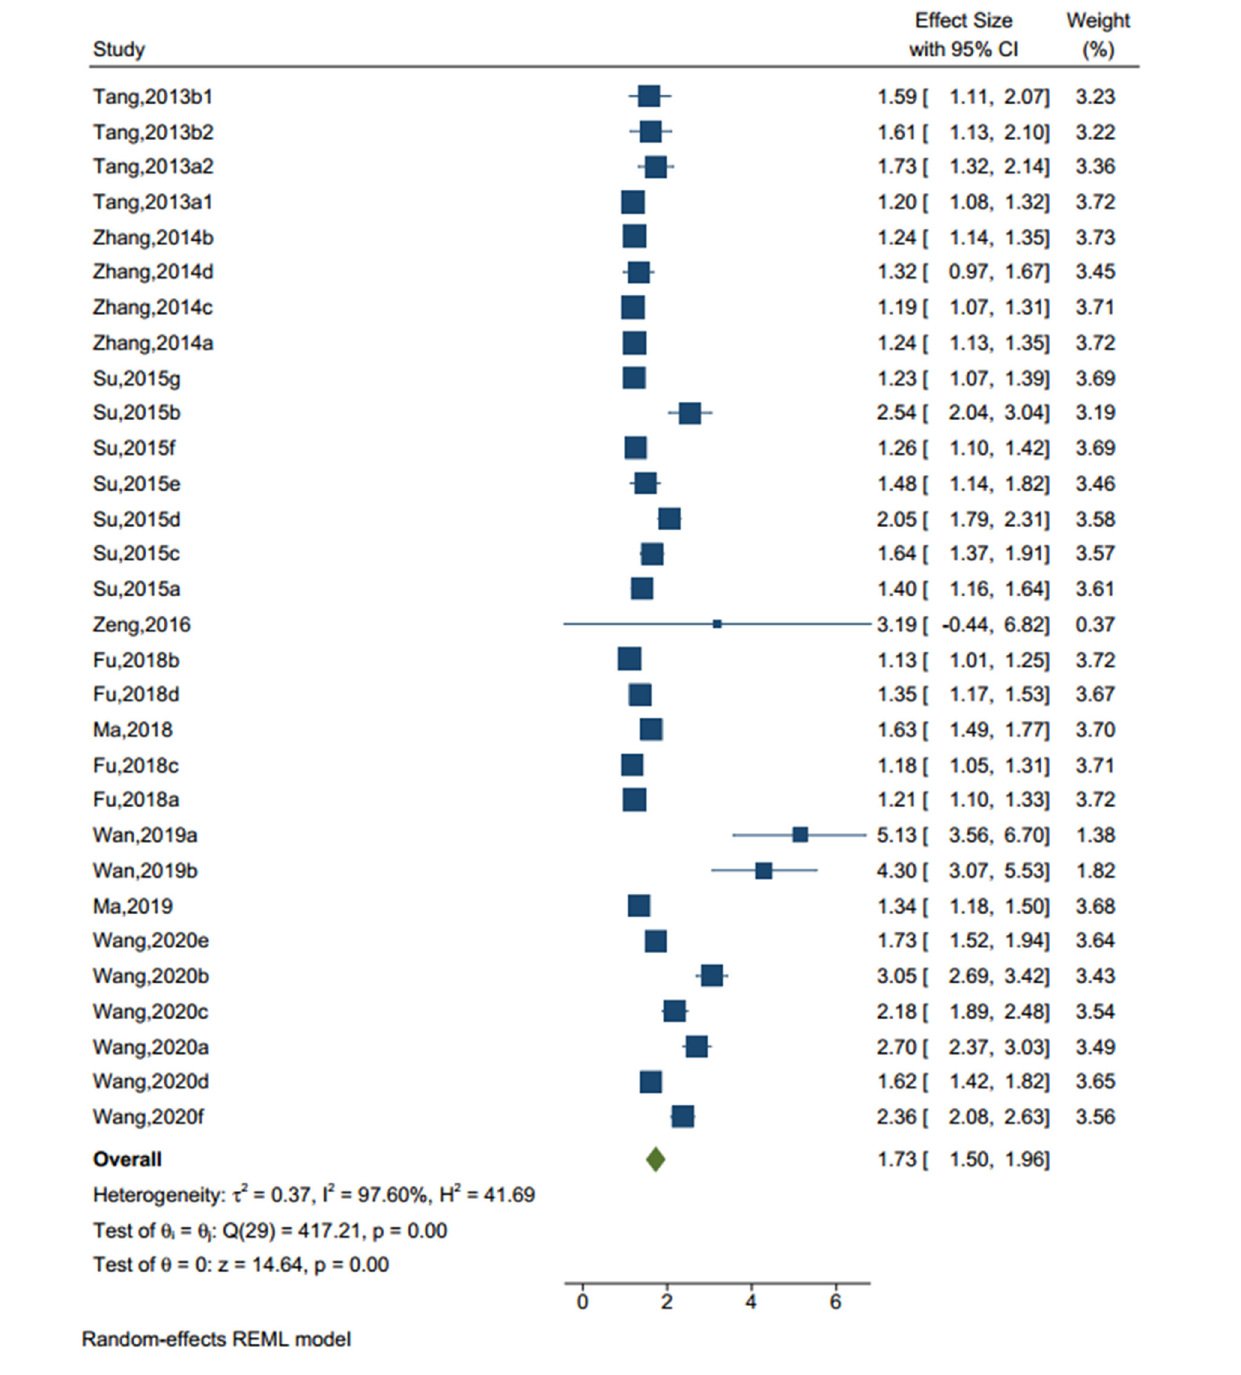
FIGURE 2 | Forest plot of studies including traumatic experience